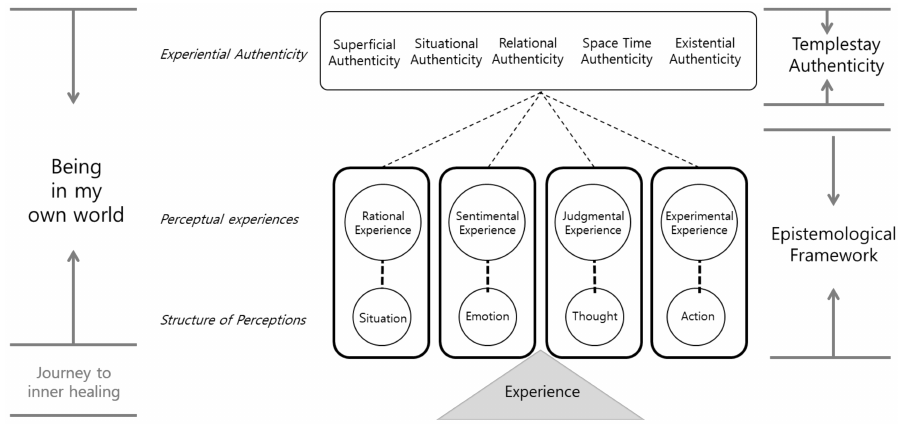
Figure 1. The descriptive model of the integrative phenomenon of templestay